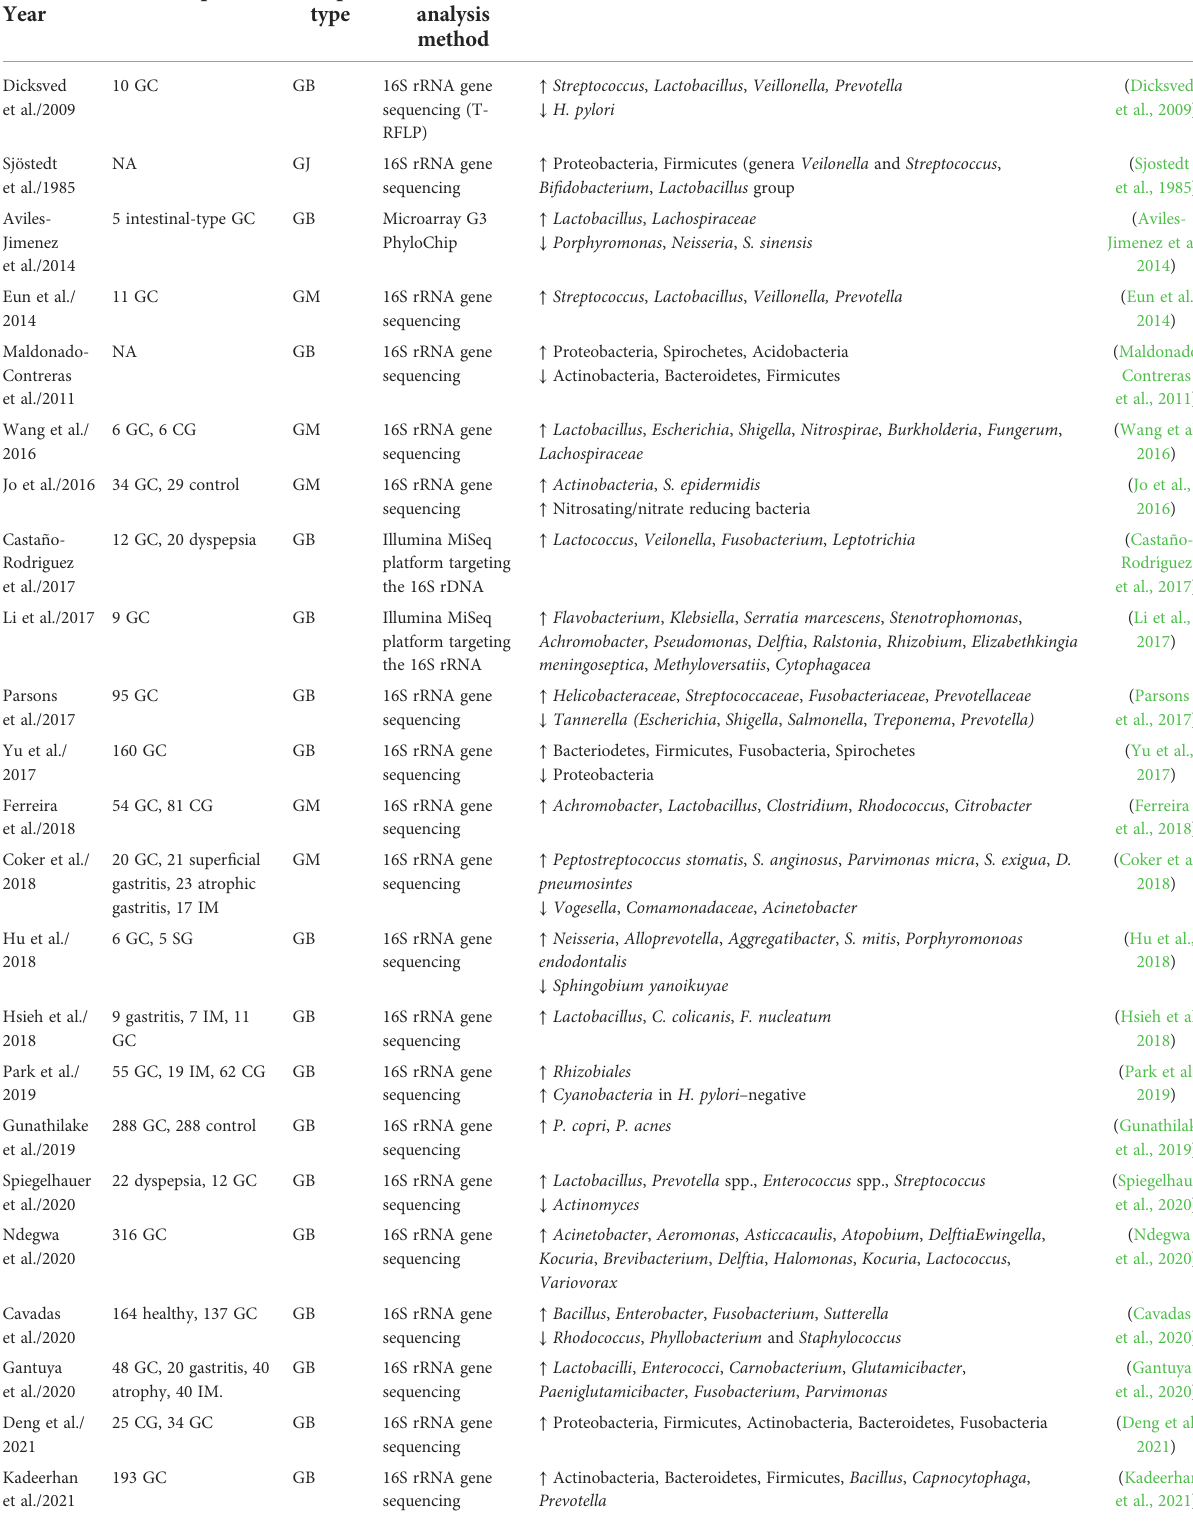
TABLE 1 Studies published on the gastric microbiome analysis in patients with gastric